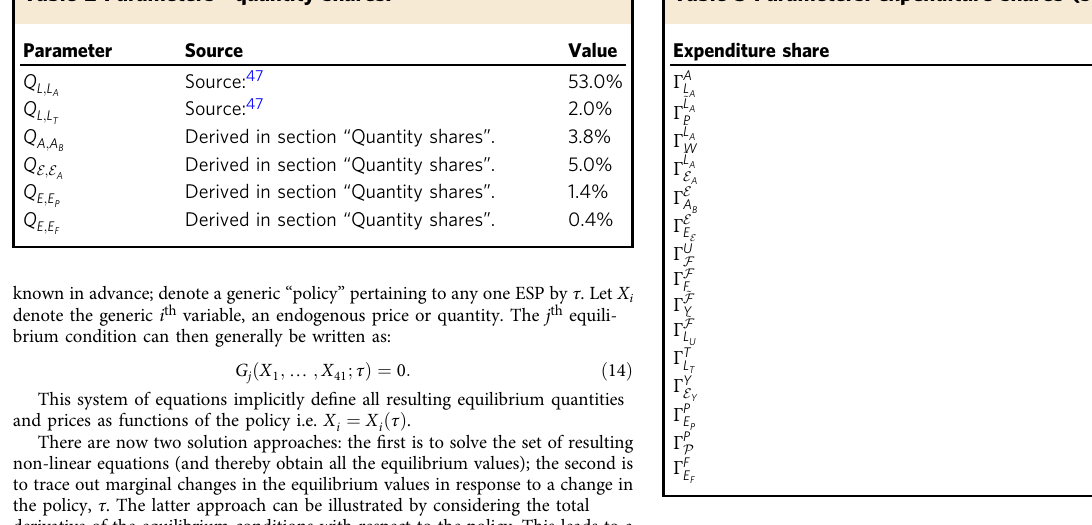
Table 2 Parameters — quantity shares. Table 3 Parameters: expenditure shares (source: